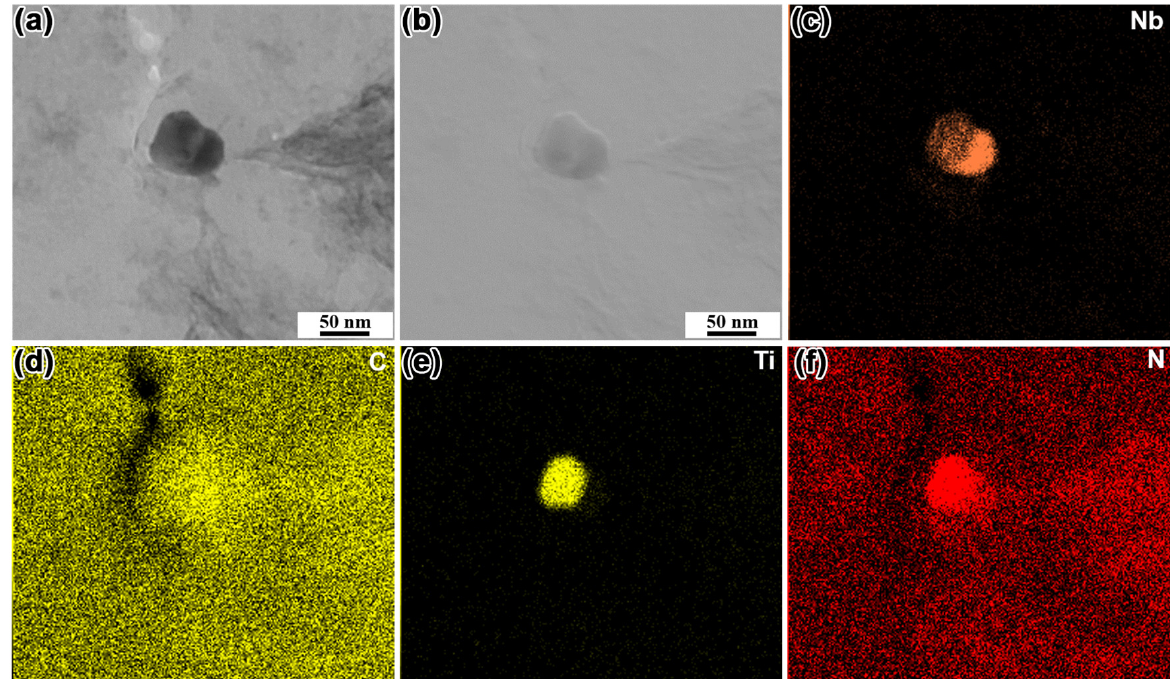
Figure 13. ( a ) STEM bright-field (BF) image of the typical precipitate, ( b ) STEM dark-field (DF) image of the typical precipitate, ( c – f ) energy-dispersive X-ray spectroscopy (EDS) mapping of the precipitate in the N1 steel without Mo addition.